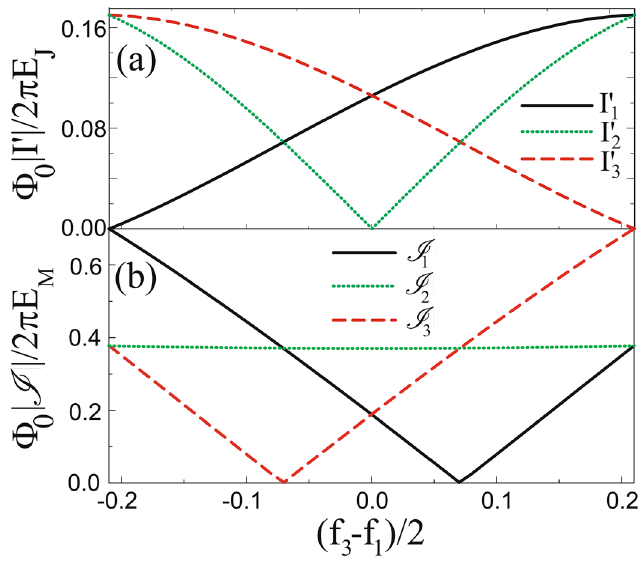
Figure 3. ( a ) Currents I ′ i in branches as a function of ( f 3 − f 1 )/ 2 . When f 1 starts from f 1 = 0.42 with f 2 = f 3 = 0 , the currents | I ′ 1 | = | I ′ 3 | �= 0 with | I ′ 1 | =0. As f 3 increases while f 1 decreases to zero, the current flow changes so that | I ′ 1 | = | I ′ 2 | �= 0 with | I ′ 3 | = 0 . ( b ) Currents I i carried through MZMs across trijunction. For f 1 = 0.42 and f 2 = f 3 = 0 the current I 1 has larger amplitude than | I 2 | = | I 3 | , but for f 3 = 0.42 and f